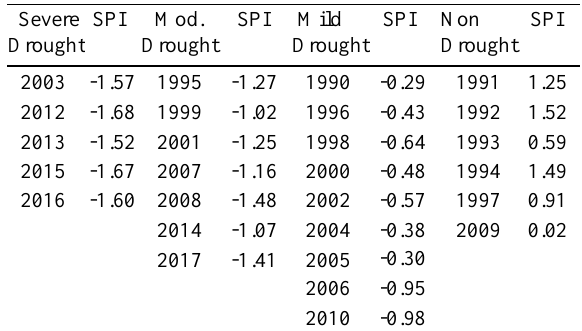
Table 2. Years of drought intensity classification based on SPI values Severe Drought